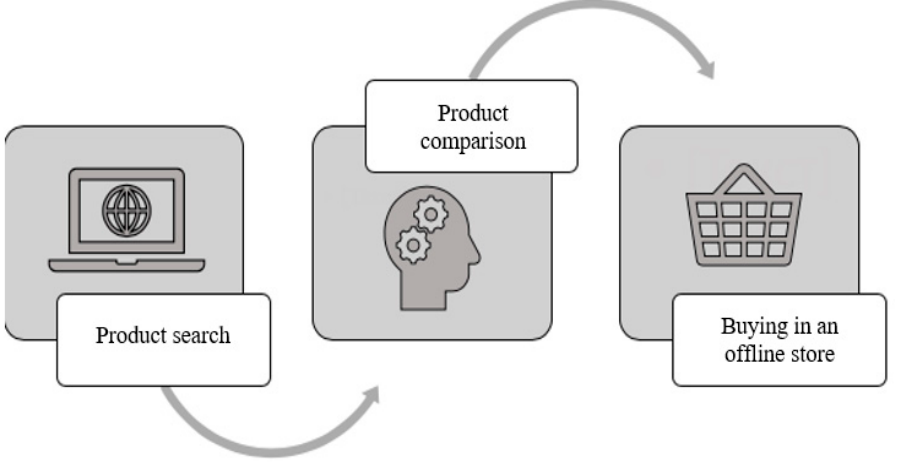
Figure 1. Product selection process in a phygital environment.